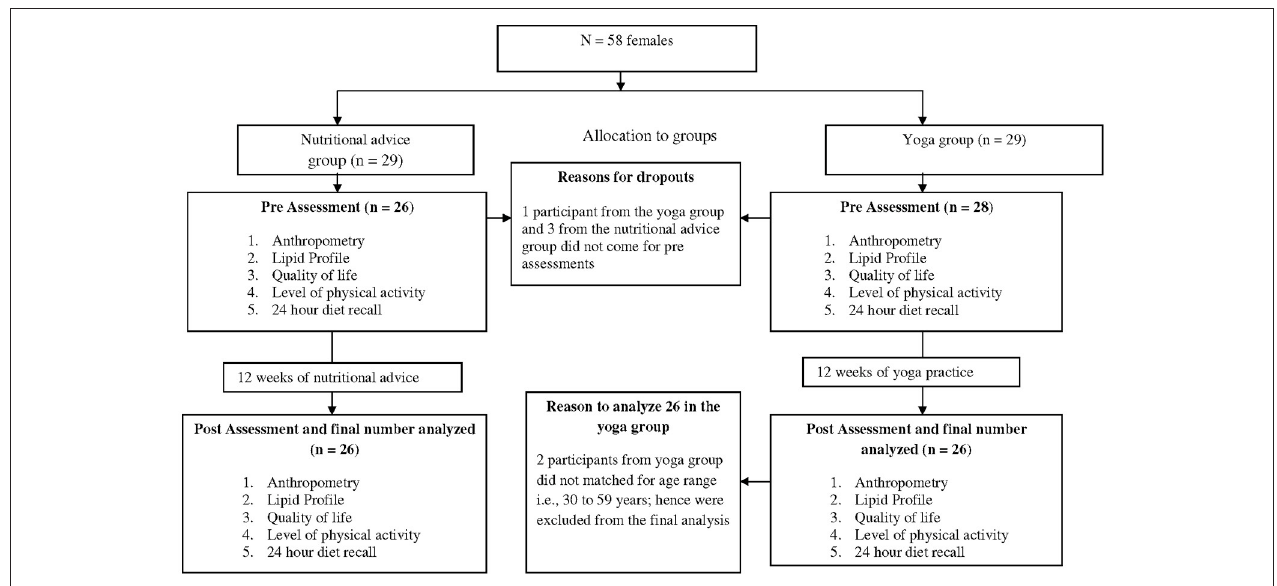
FIGURE 1 | Trial profile of the study.